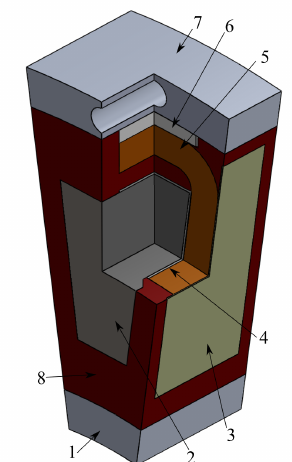
Figure 9. Concentrated winding tooth coil: (1) Aluminium thermal end-winding interconnection ring; (2) Laminated iron core; (3) Mica inter coil insulation sheet; (4) Mica slot liner; (5) Winding body; (6) Aluminium-oxide thermal pad; (7) Aluminium housing; (8) Epoxy